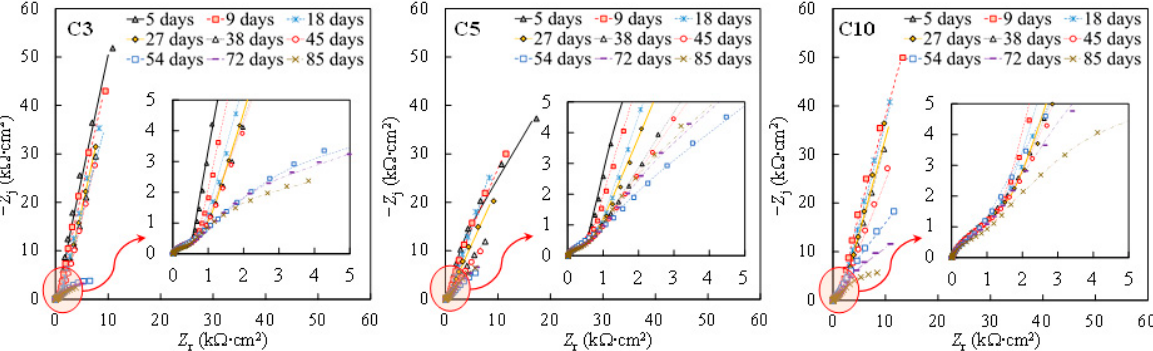
Figure 8. Nyquist plots of the stressed specimens when coupled to the non-stressed steel. Symbol: experimental results. Line: fitting results.